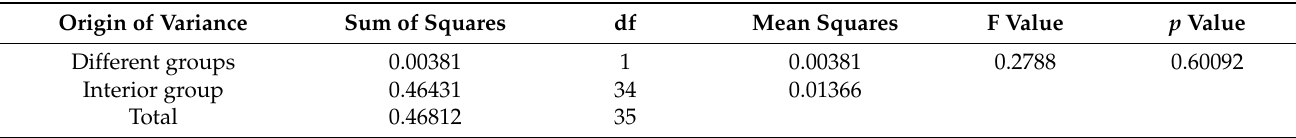
Table 2. ANOVA results of simulation and experiment.